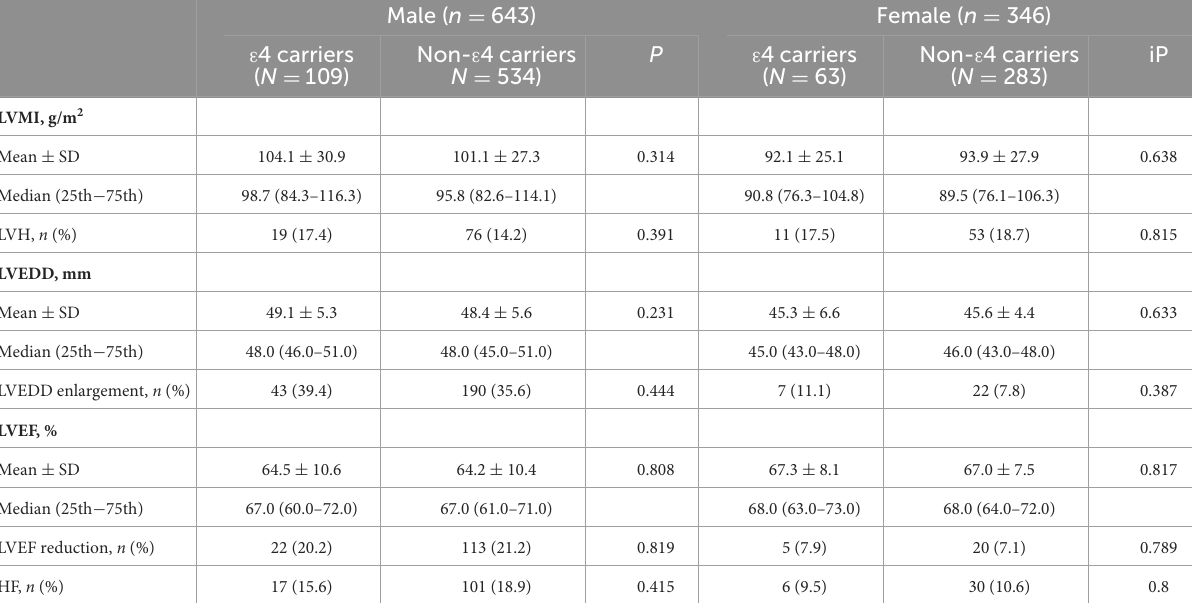
TABLE 2 Comparison of cardiac